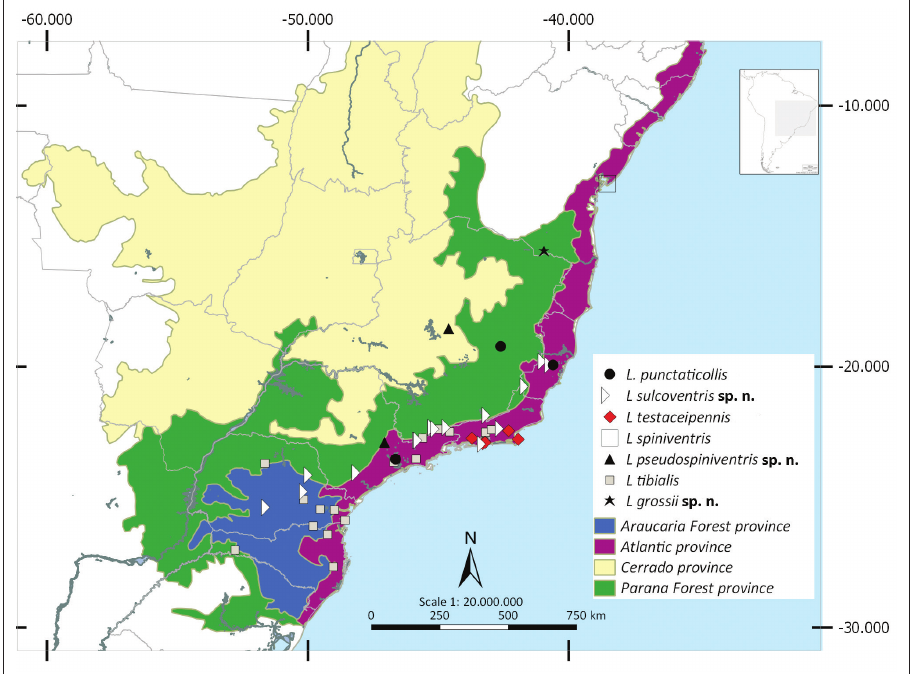
Figure 90. Distribution records of seven species of Liogenys . Biomes based on Morrone (2014). the pronotum; elytral suture slightly darker than elytron and distinctly elevated; two pairs of inner ridges more noticeable than the two outer pairs. Legs: procoxa scaly on infra-carinal and outer surface; punctures visible at 12× magnification; three protibial teeth, middle and apical equal in size, the three teeth equally spaced; protibial in- ner apical spur present; mesofemural disc setose, scarcely bristled; mesotibia quadrate in cross section; disc coarsely sculptured, mesotibial apical carina incomplete; basal apophysis of metacoxa produced beyond the outer margin of trochanter; metafemur strongly produced medially on posterior margin; inner margin of metatibia carinated and medially produced towards apex, apical inner surface setose; metatibial disc finely sculptured; two metatibial transverse carina present posteriorly and posterior discon- tinuous longitudinal carina; metatibial apical spurs of different lengths, the longest shorter than the diameter of the tibial apex; protarsomere II long; pro- and mesotar- someres I to IV enlarged, protarsomeres two-fold wider than the mesotarsomeres and more than twice than the metatarsi; basal metatarsomere and tarsomere II equal in size; claw bifid, symmetrical, superior tooth as long as and narrower than the inferior; distance between teeth shorter than the inferior tooth. Abdomen: ventrites bristled on disc; ventrites I, II and III sulcated medially, IV slightly elevated; propygidium vis- ible, bearing few short bristles; pygidium convex, sub-quadrate, as wide as it is long; pygidial width not exceeding distance between spiracles of propygidium, pygidial disc bristled only on apex; pygidial apex quadrate. Parameres: width of basal region equal